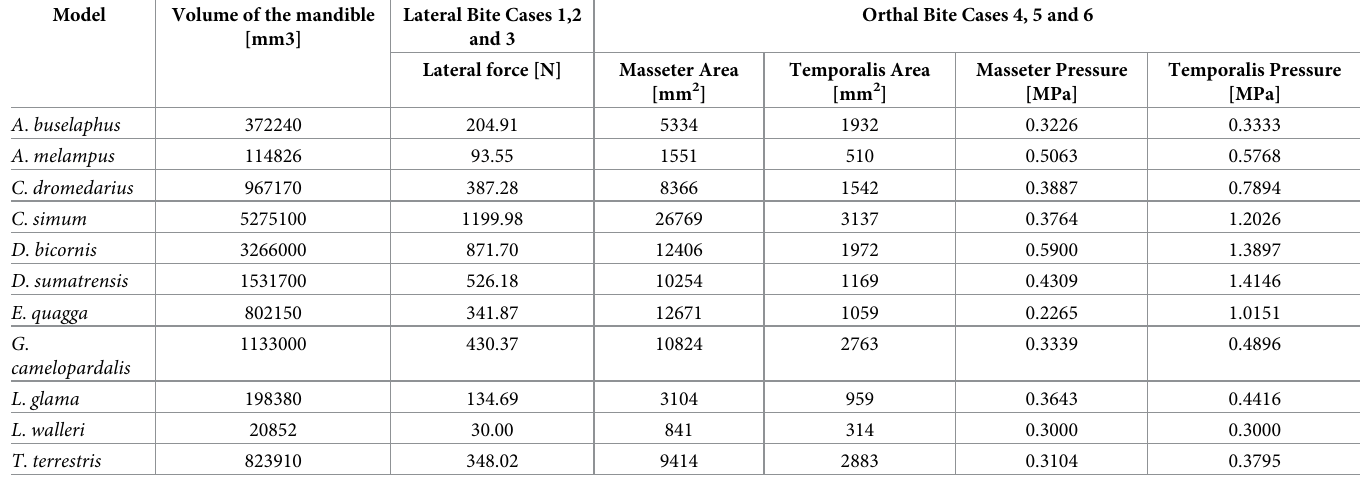
Table 2. Geometric properties and muscular pressure. Volume of the mandible [mm 3 ], masseter and temporalis area [mm 2 ] and muscular pressure [MPa] applied in the FEA model for each species.